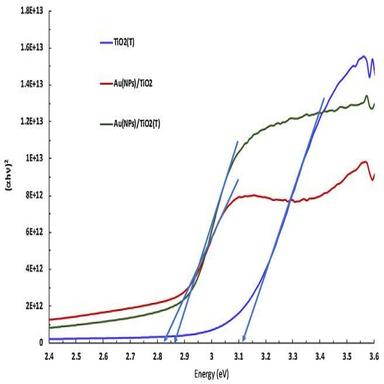
Plots between hn (Energy) vs (αhn) 2 for the bare TiO2, Au0 (NPs)/TiO2(A) and Au0 (NPs)/TiO2(B) solids.